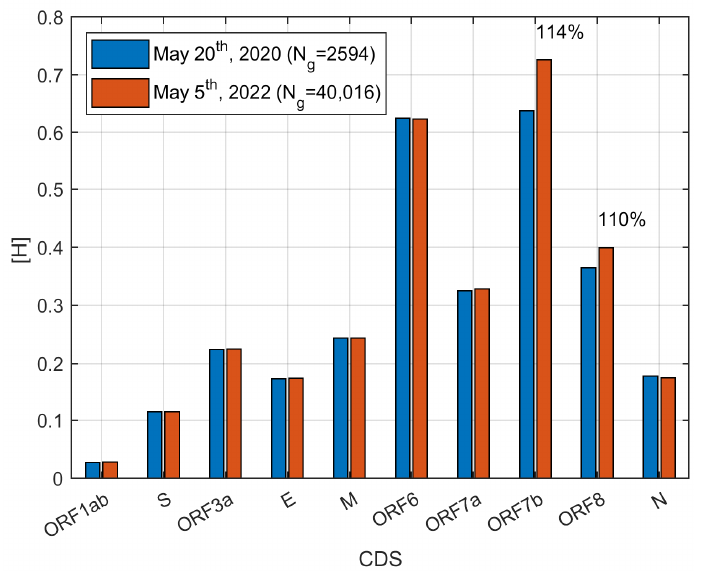
Figure 2. The mean HGS of ORF 7b and ORF 8 increased to 114% and 110% from 20 May 2020 to 5 May 2022. The HGS of other ORFs remained at almost the same level.